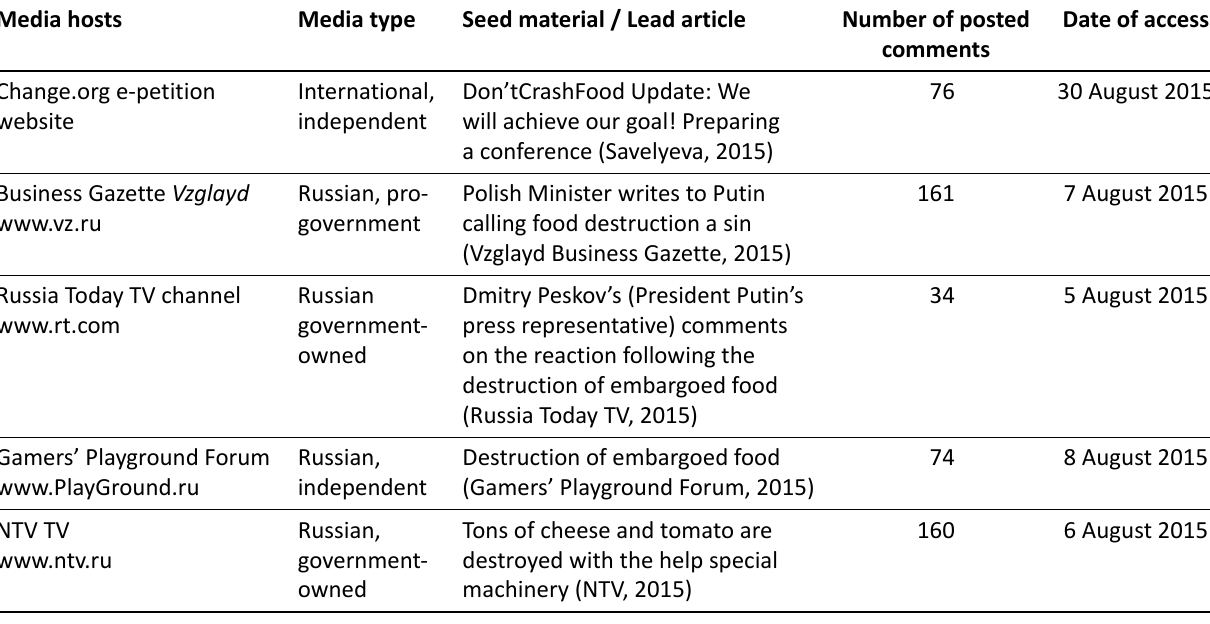
Table 1. List of media